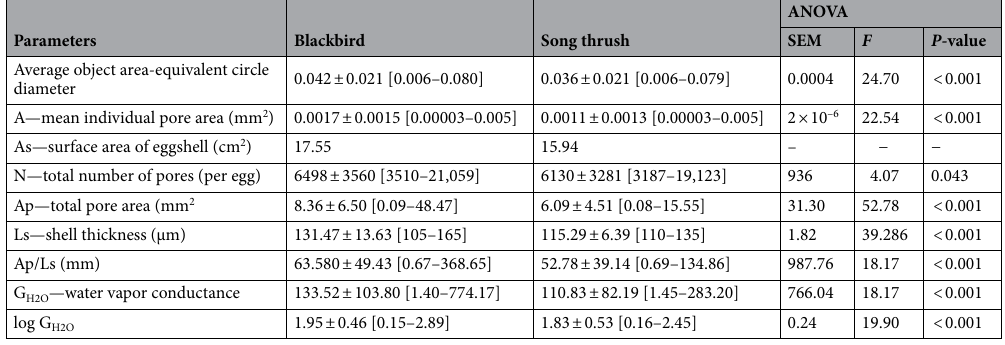
Table 3. 2D microstructure parameters and water vapor conductance of blackbird and song thrush eggshell.